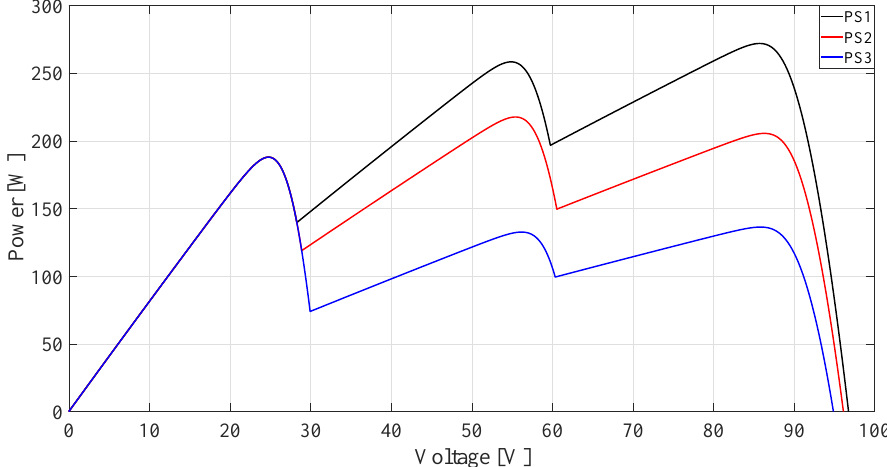
Figure 15. Complex partial shading cases using Matlab/Simulink PV